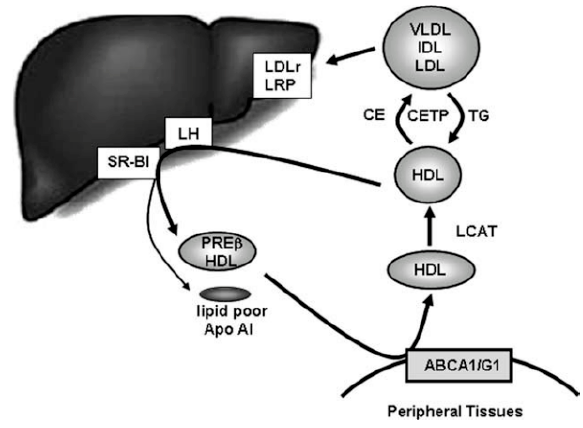
Figure 6. Stages involved in the reverse cholesterol transport (RCT), which favours the cholesterol transport to the liver for its excretion. Figure reproduced with permission from Oliveira and De Faria, 2011 [99]. LDLr: LDL receptors; LRP: LDL receptor-related proteins; CE: Cholesteryl ester; SR-BI: Scavenger receptor class B type I; VLDL: Very low-density lipoprotein; LH: Hepatic lipase; IDL: Intermediate-density lipoproteins; TG: Triglycerides; CETP: Cholesterylester transfer protein; LCAT: lecithin cholesterol acyl transferase; ABCA1/G1: ATP binding cassette transporter A1 or G1; Apo AI: